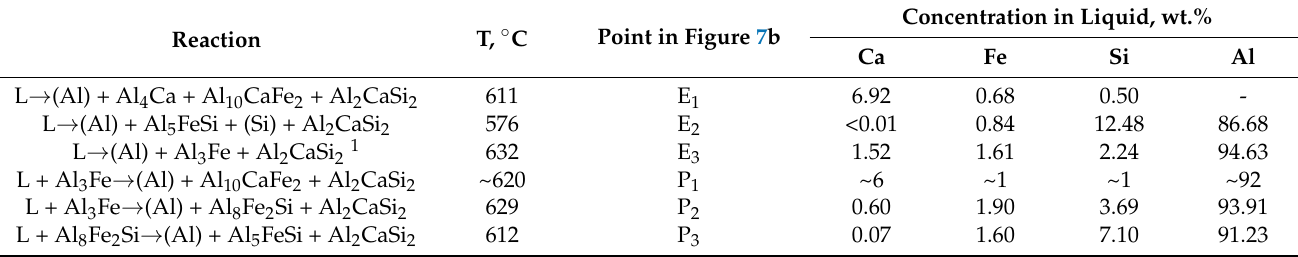
Table 5. Calculated parameters of invariant reactions in the Al–Ca–Fe–Si